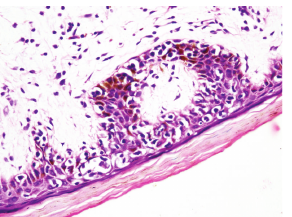
Figure 7: Atypical lymphocytes showing epidermotropism and formation of Pautrier’s microabscesses (H&E stain, 400x) (patient 2).